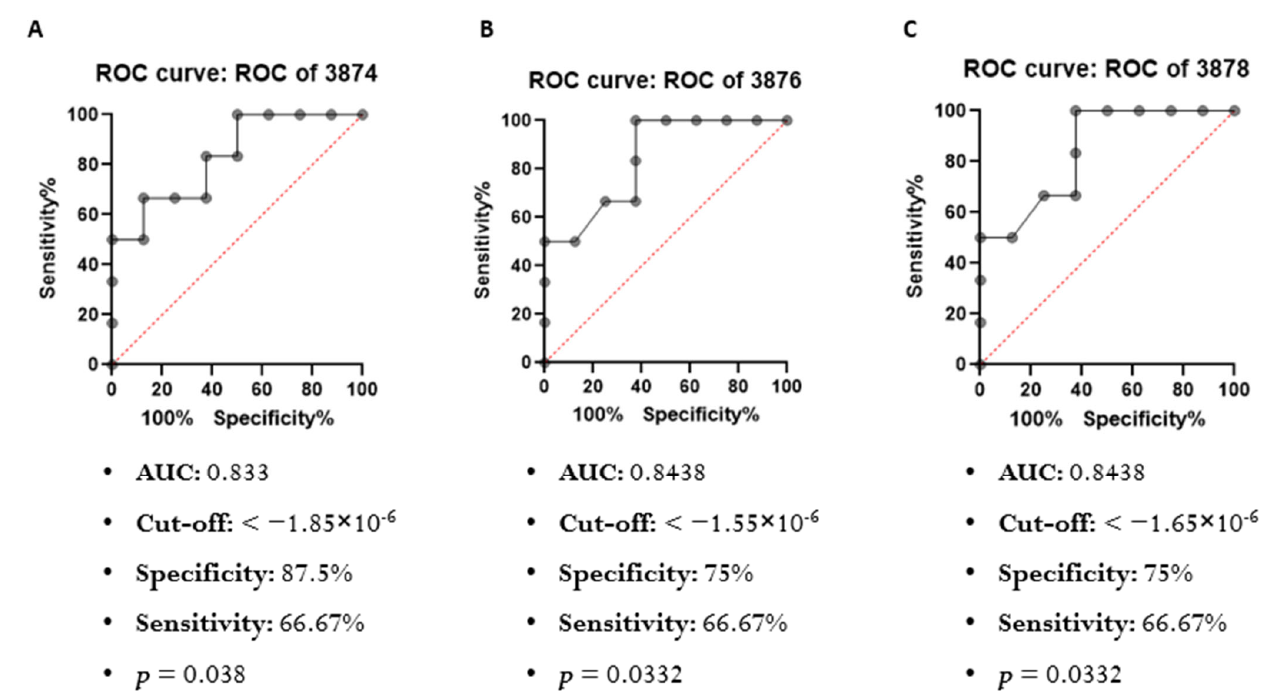
− 1 ; ( B ) 3876 cm − 1 ; ( C ) 3878 cm − 1